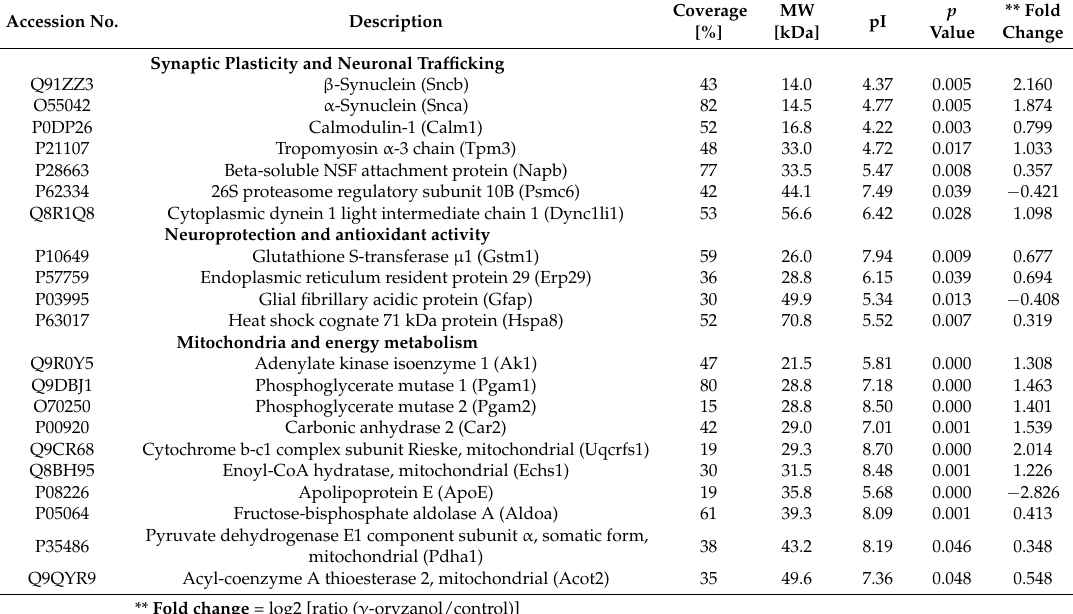
Figure 2. 2D-difference gel electrophoresis (2D-DIGE) hippocampal proteome map of mice treated with γ -oryzanol or vehicle (control). 2D-DIGE proteome map shows the overlap between γ -oryzanol (green) and control (red) hippocampal proteome maps, and the overlapped spots are present in yellow. Mr: relative molecular mass. Some protein spots are shown enlarged in grey scales for better spot visualization ( A – D ). Table 1. List of the proteins modulated by γ